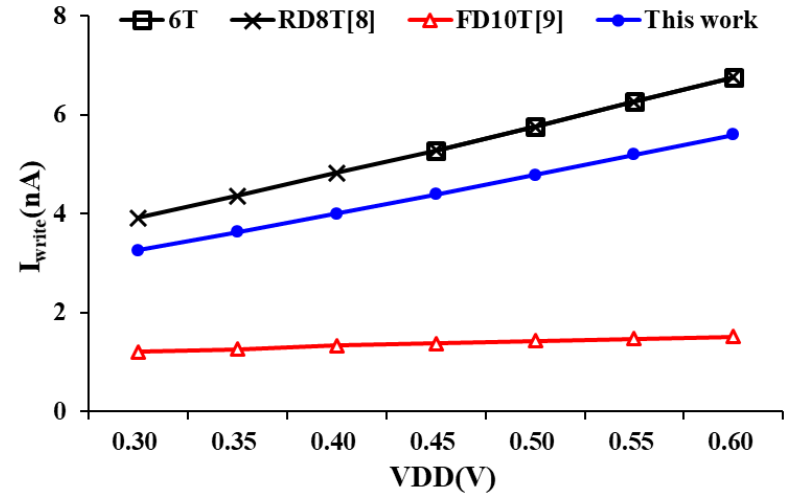
Figure 10. Bit-cell write current comparison at different voltages.